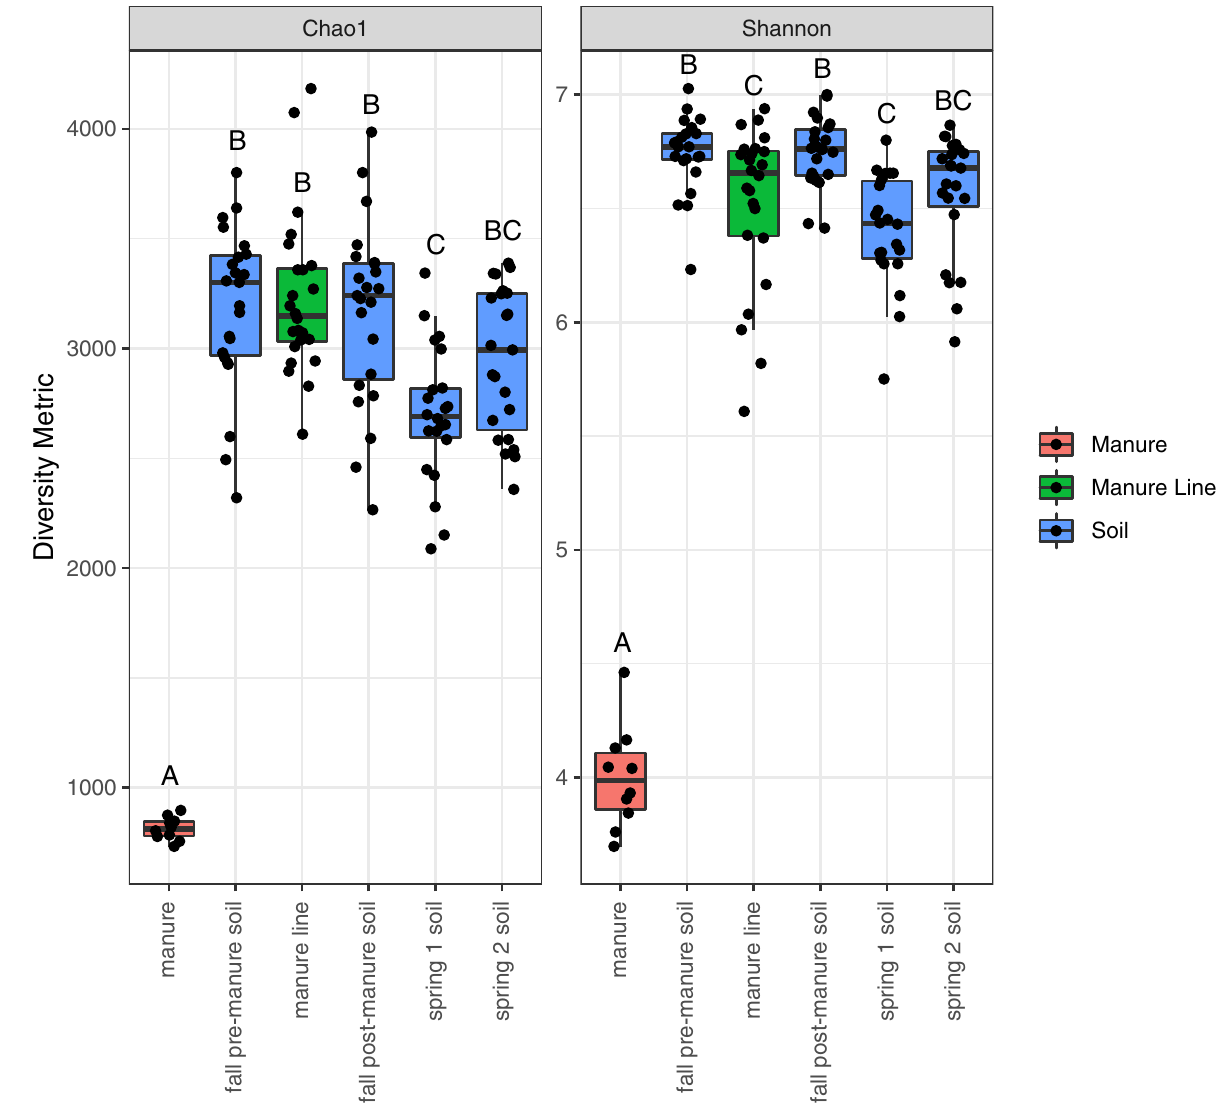
Fig 2. Alpha diversity indices of microbiome samples. Boxplots represent 25th to 75th percentiles and whiskers showing a maximum of 1.5x the interquartile range (IQR). Different letters indicate significant differences within the alpha diversity indexes (P < 0.05).